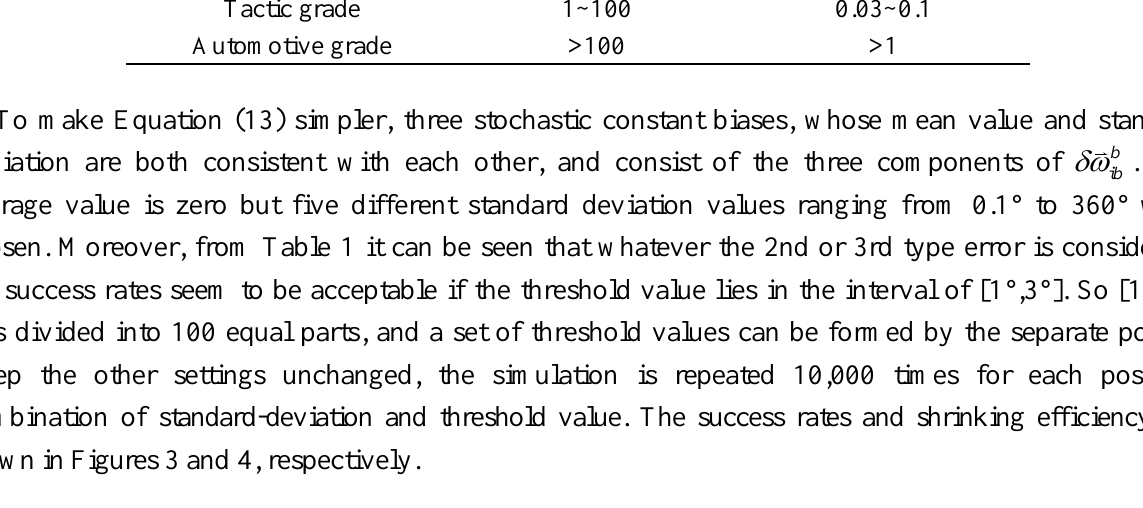
Figure 3. Success rate varies with threshold at different accuracy levels of gyroscope.